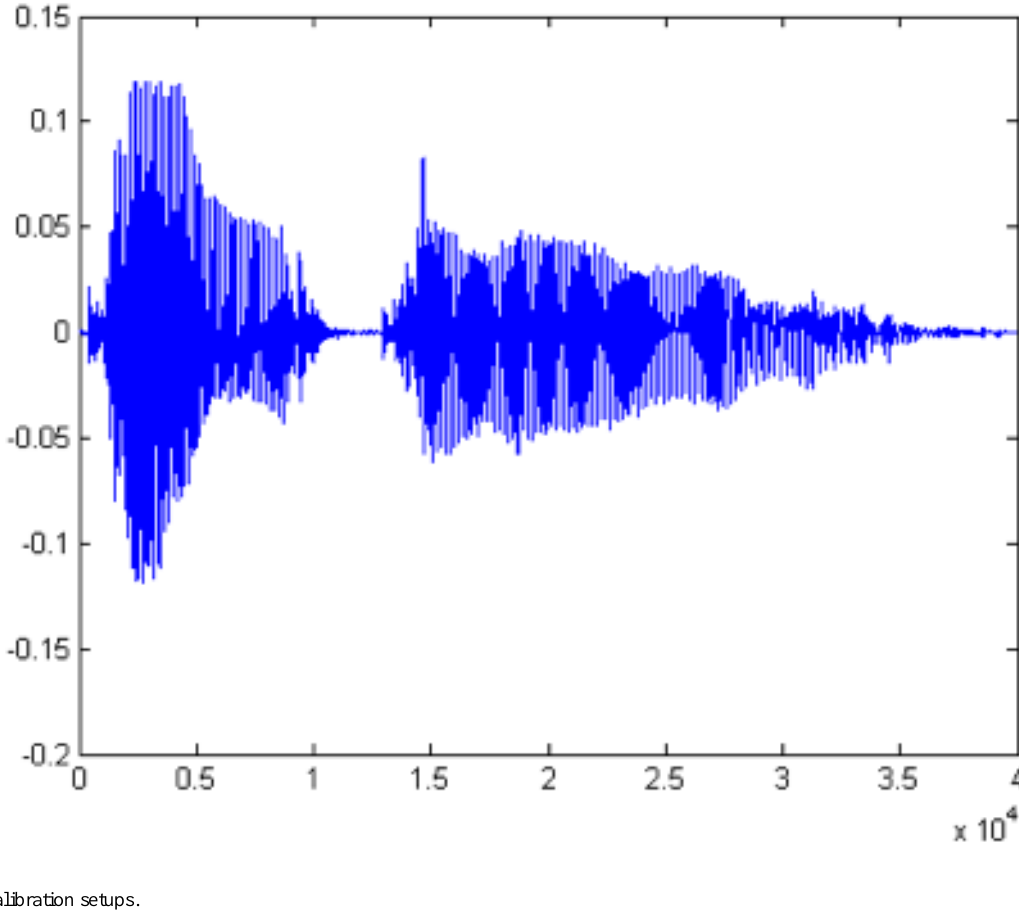
Figure 3. Calibration